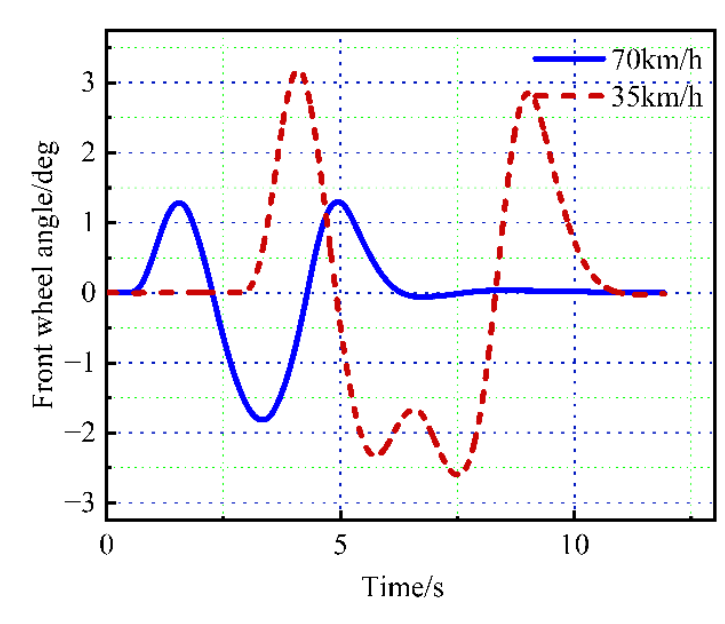
Figure 10. Change curve of vehicle front wheel angle.